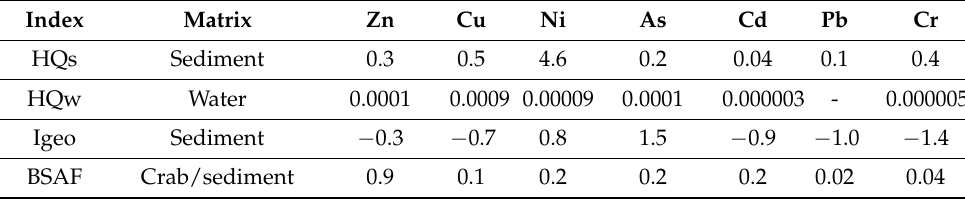
Table 3. Results of the Igeo, BSAF, and HQ for the different